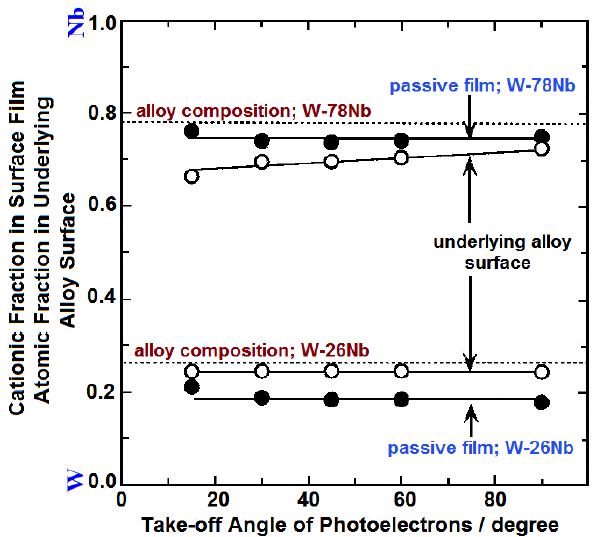
Figure 4: A model of the uniform passive and underlying surfaces formed on the W-xNb